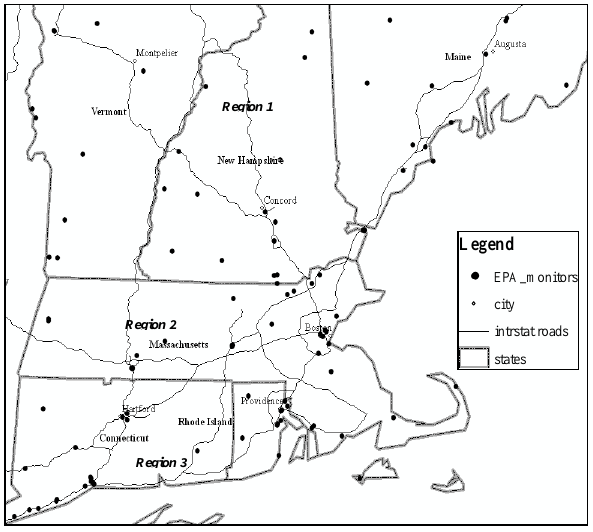
Fig. 1. Study area and EPA monitoring sites for New England used Figure 1.Study area and EPA monitoring sites for New England used for comparison between for comparison between MYD04 and MAIAC MYD04 and MAIAC data.